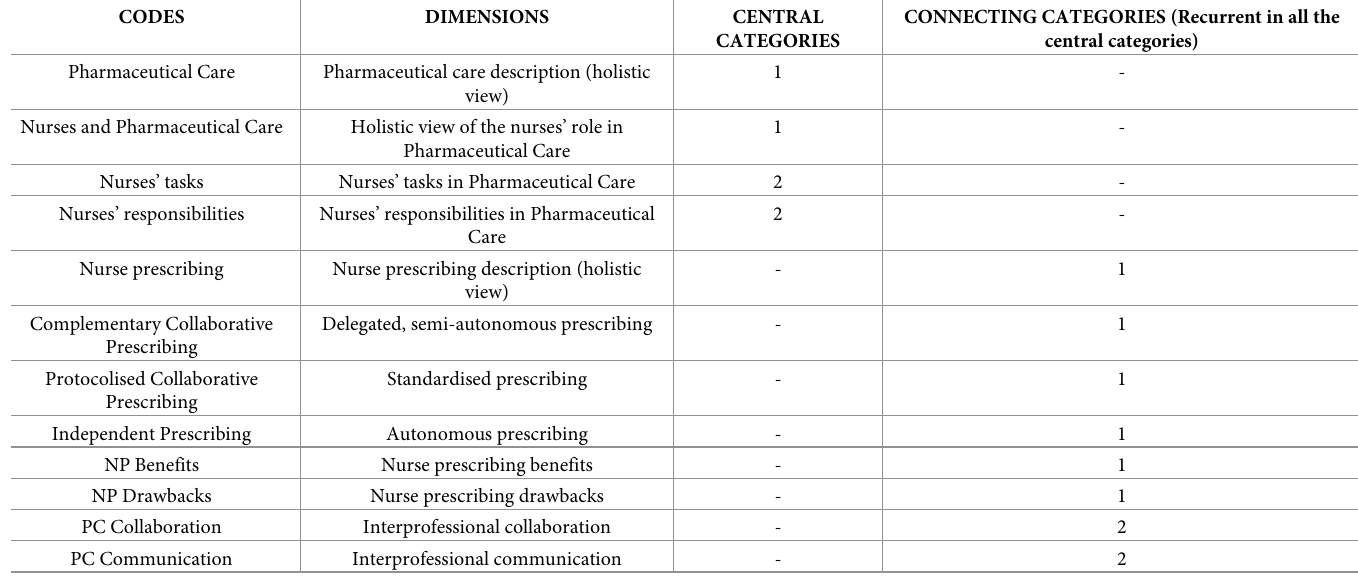
Table 2. Data analysis